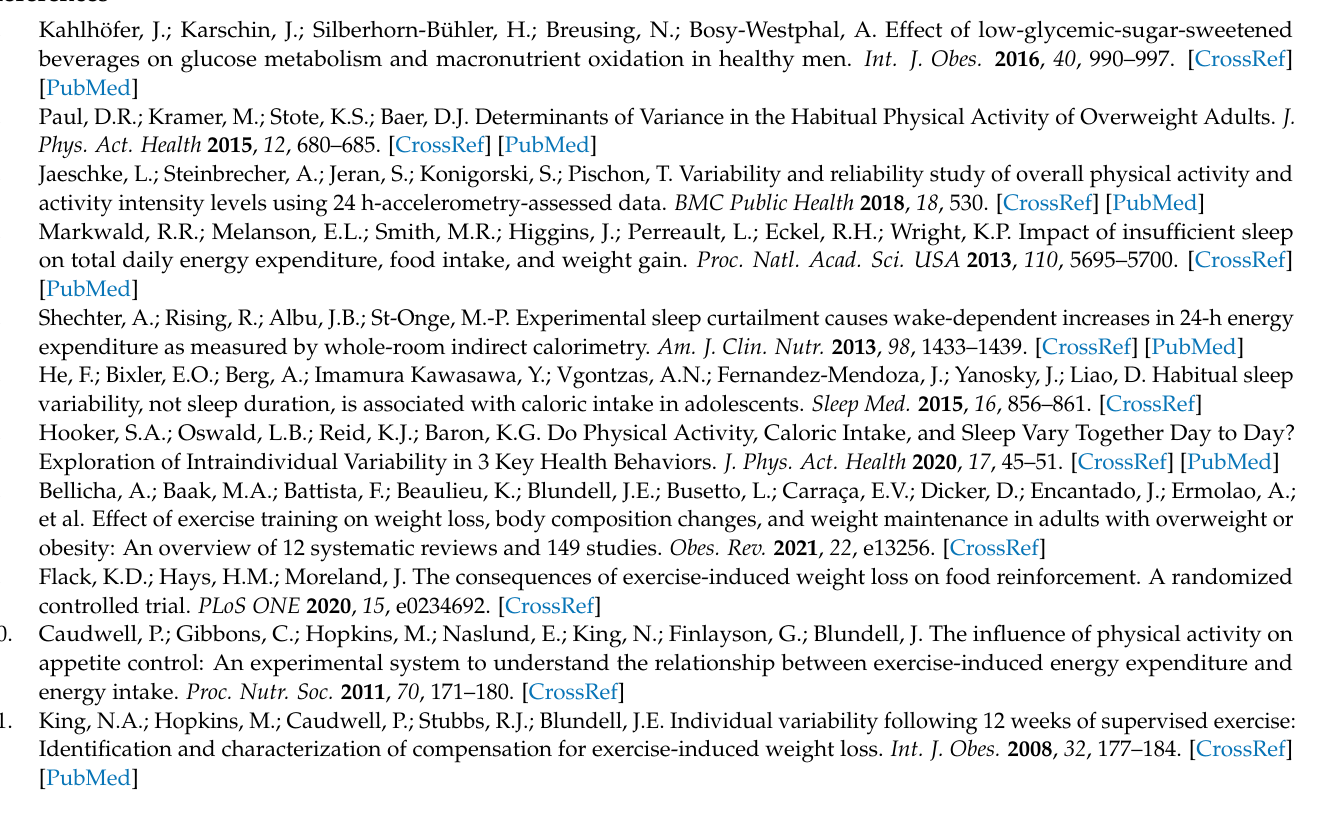
Table 1. Impact of different types of energy expenditure on energy intake and energy balance. EE EI EB high protein intake ↑ ↓ ↓ high habitual PAL ↑ ↓ ( ↑ ) ↓ cold exposure ↑ ↑ ↑ heat stress ↑ ↓ ↓ EB, energy balance; EE, energy expenditure; EI, energy intake; PAL, physical activity